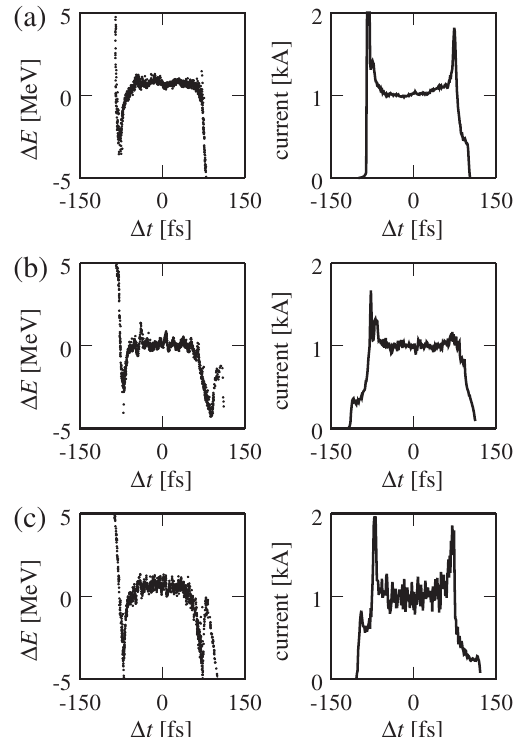
FIG. 6. Simulations of microbunching from shot noise. The left-hand plots show the longitudinal phase space while the right- hand plots show 200-bin current histograms at the exit of the beam spreader. (a) Dechirping the compressed bunch by 40 (cid:2) off- crest acceleration. (b) Dechirping by two dechirping cells at beam energy of 400 MeV (16 bending magnets in four chicanes). (c) Dechirping by two dechirping cells at beam energy of 1.7